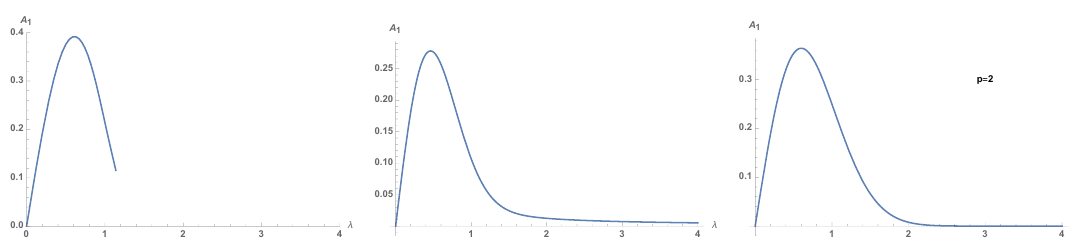
Figure 25 . Gauge (cid:12)eld as a function of the Wilson line coupling constant, left in Siegel gauge, center for the TT/KOS solution (with t = 5 in [29]), and right from the shifted 3-point function.